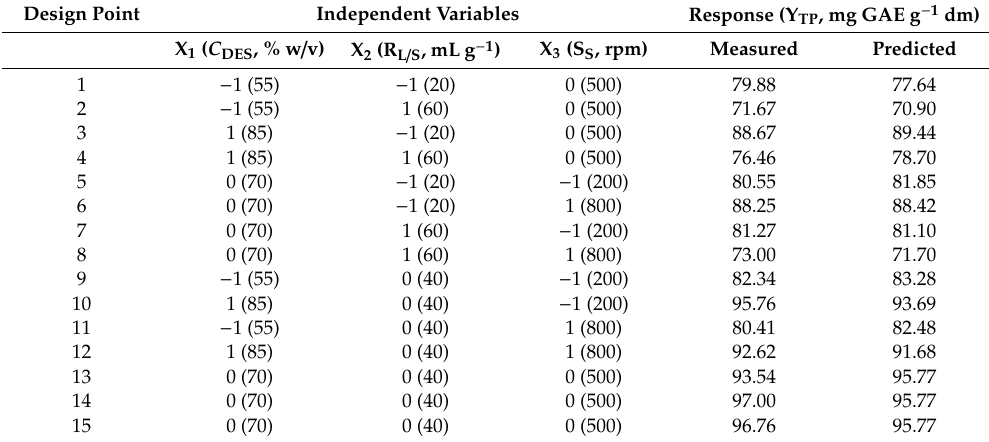
Table 4. Experimental design points and corresponding measured and predicted